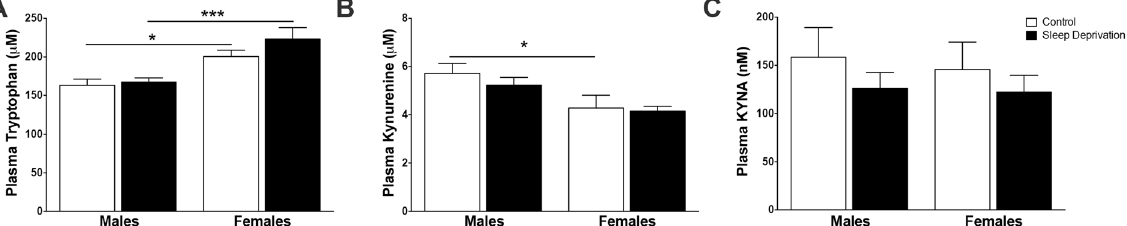
Figure 4. No change to peripheral tryptophan, kynurenine, or KYNA after sleep deprivation. Male and female animals were sleep deprived for 6 h from ZT 0 to ZT 6. (A) Plasma tryptophan. (B) Plasma kynurenine. (C) Plasma KYNA. All data are mean ± SEM. * P < 0.05, *** P < 0.001. N = 9 per group.